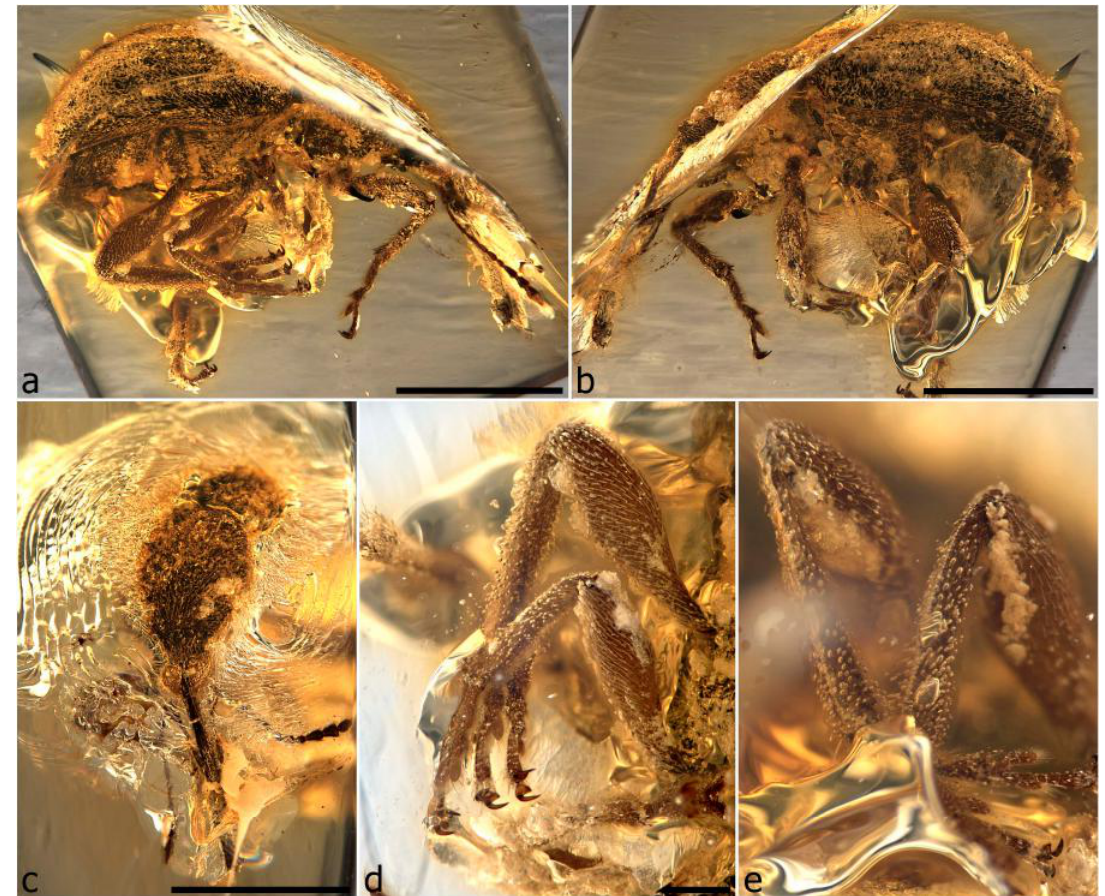
Figure 70. Myanmarus robustus sp. n., holotype. Habitus, right lateral ( a ); habitus, left lateral ( b ); head and prothorax, dorsal ( c ); legs, ventrolateral ( d ); tibiae ( e ). Scale bars: 1.0 mm (a–c); 0.2 mm (d). Material examined. Holotype (NIGP157014): well preserved, intact specimen, not compressed or distorted, mostly well visible except for left side of rostrum, pronotum, and legs posteriorly; obliquely transverse in rectangular cuboid 4.6 × 3.3 × 2.2 mm; amber clear except for large reflective thin film of flow lines over rostrum, pronotum and basal part of elytra, with shallow crack along side of right elytron, transverse crack across elytral declivity and large, irregular, clear bubble beneath